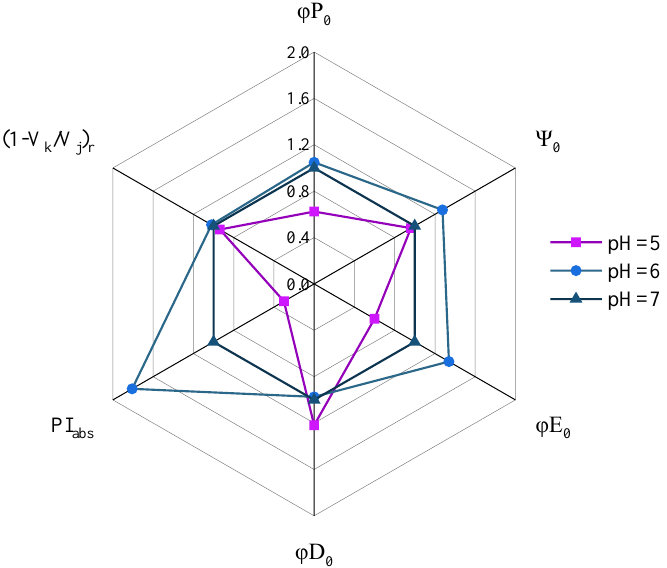
Figure 3. The parameters of PI abs , φ E 0 , φ P 0 , ψ 0 , φ D 0 , and (1 − V k /V j ) r deviated from chlorophyll fluorescence transients. The values of each parameter were normalized using that of neutral control (pH 7.0).